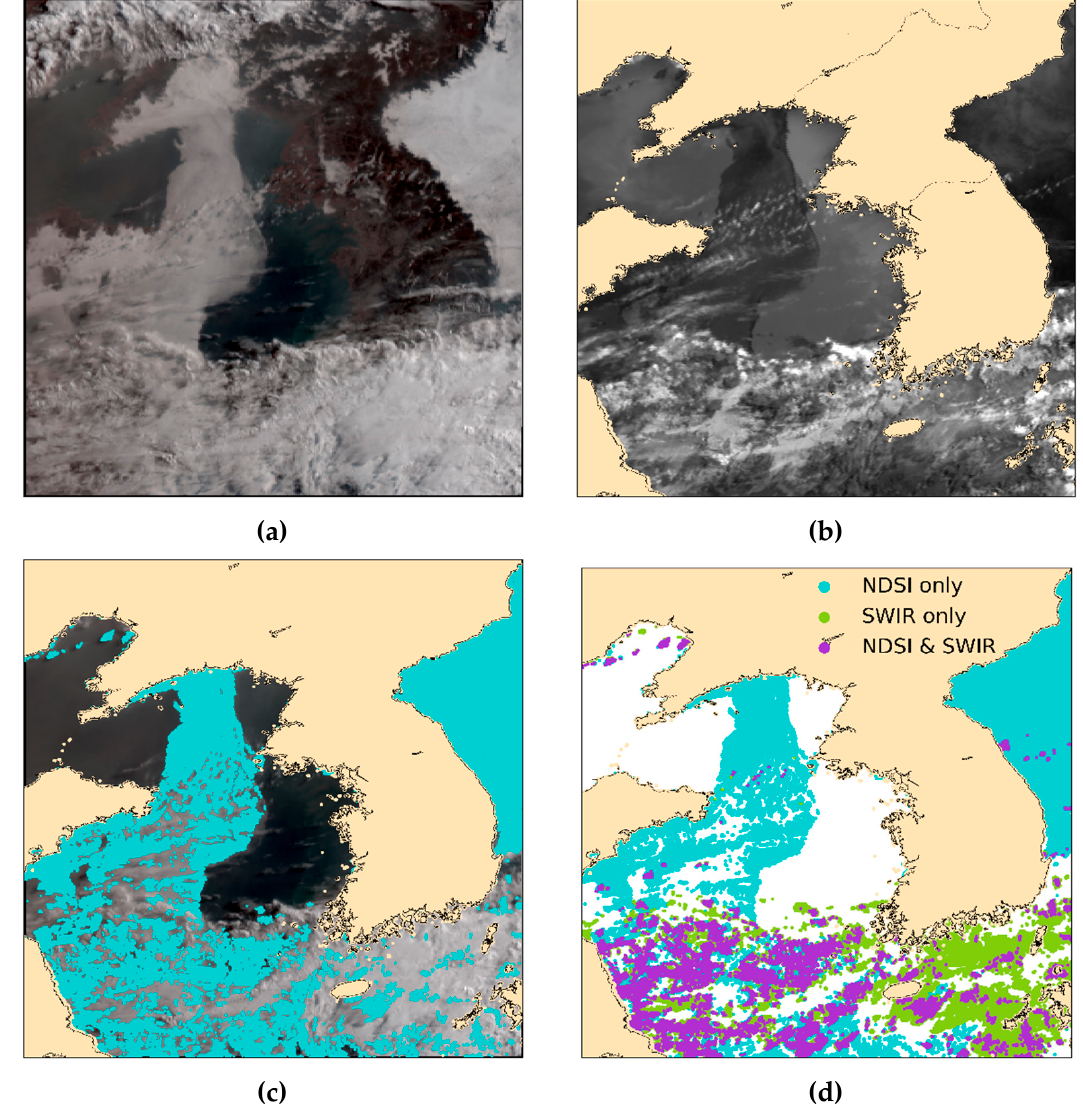
Figure 12. Case of sea fog in the twilight condition (27 May 2018, at 22:30 UTC) in ( a ) RGB image, ( b ) the brightness temperature at AHI 3.9 µ m, ( c ) the proposed sea fog algorithm, and ( d ) the results of two sea fog algorithms.